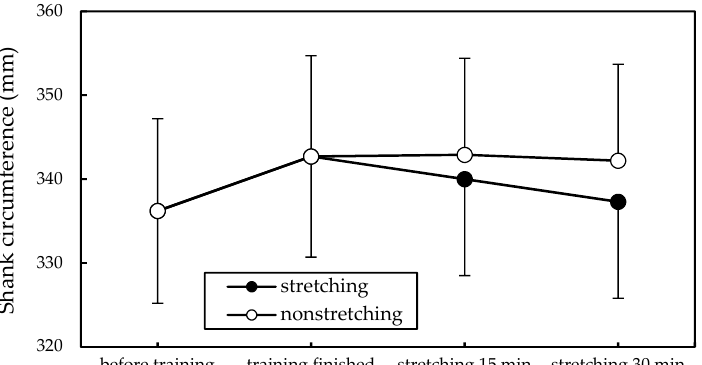
Figure 3. Comparison of shank circumferences (mean with standard deviation) at different measurement stages.